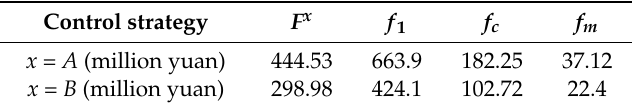
Table 4. Economical comparison of two control